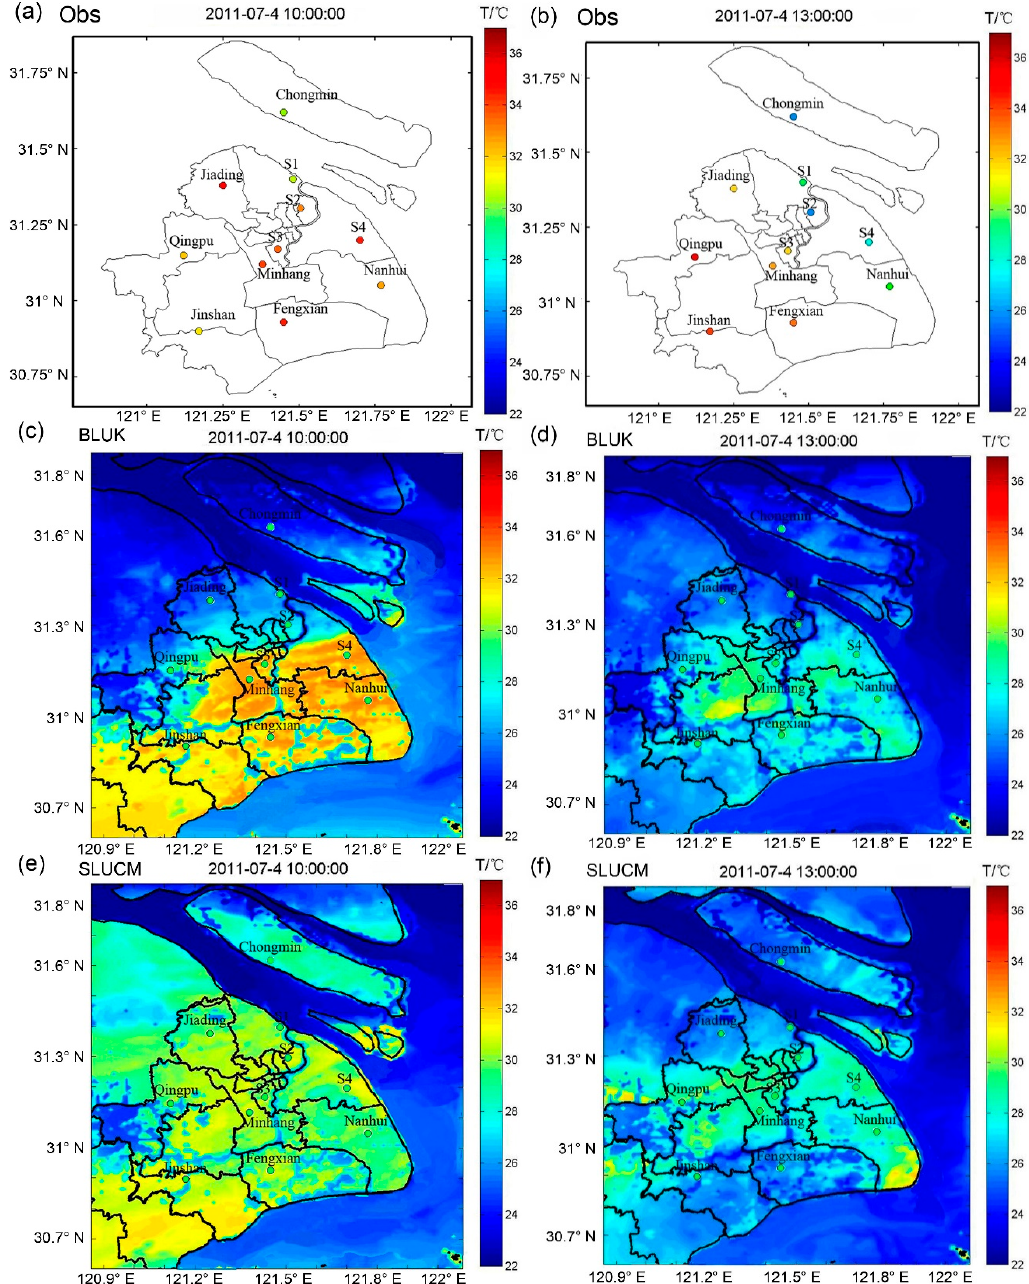
Figure 8. Horizontal distributions of observed temperatures at 11 sites in Shanghai and simulated temperatures over Shanghai on 4 July 2011 ( a ) Observed temperatures at 10:00; ( b ) Observed temperatures at 13:00; ( c ) Simulated temperatures by BULK at 10:00; ( d ) Simulated temperatures by BULK at 13:00; ( e ) Simulated temperatures by SLUCM at 10:00; ( f ) Simulated temperatures by SLUCM at